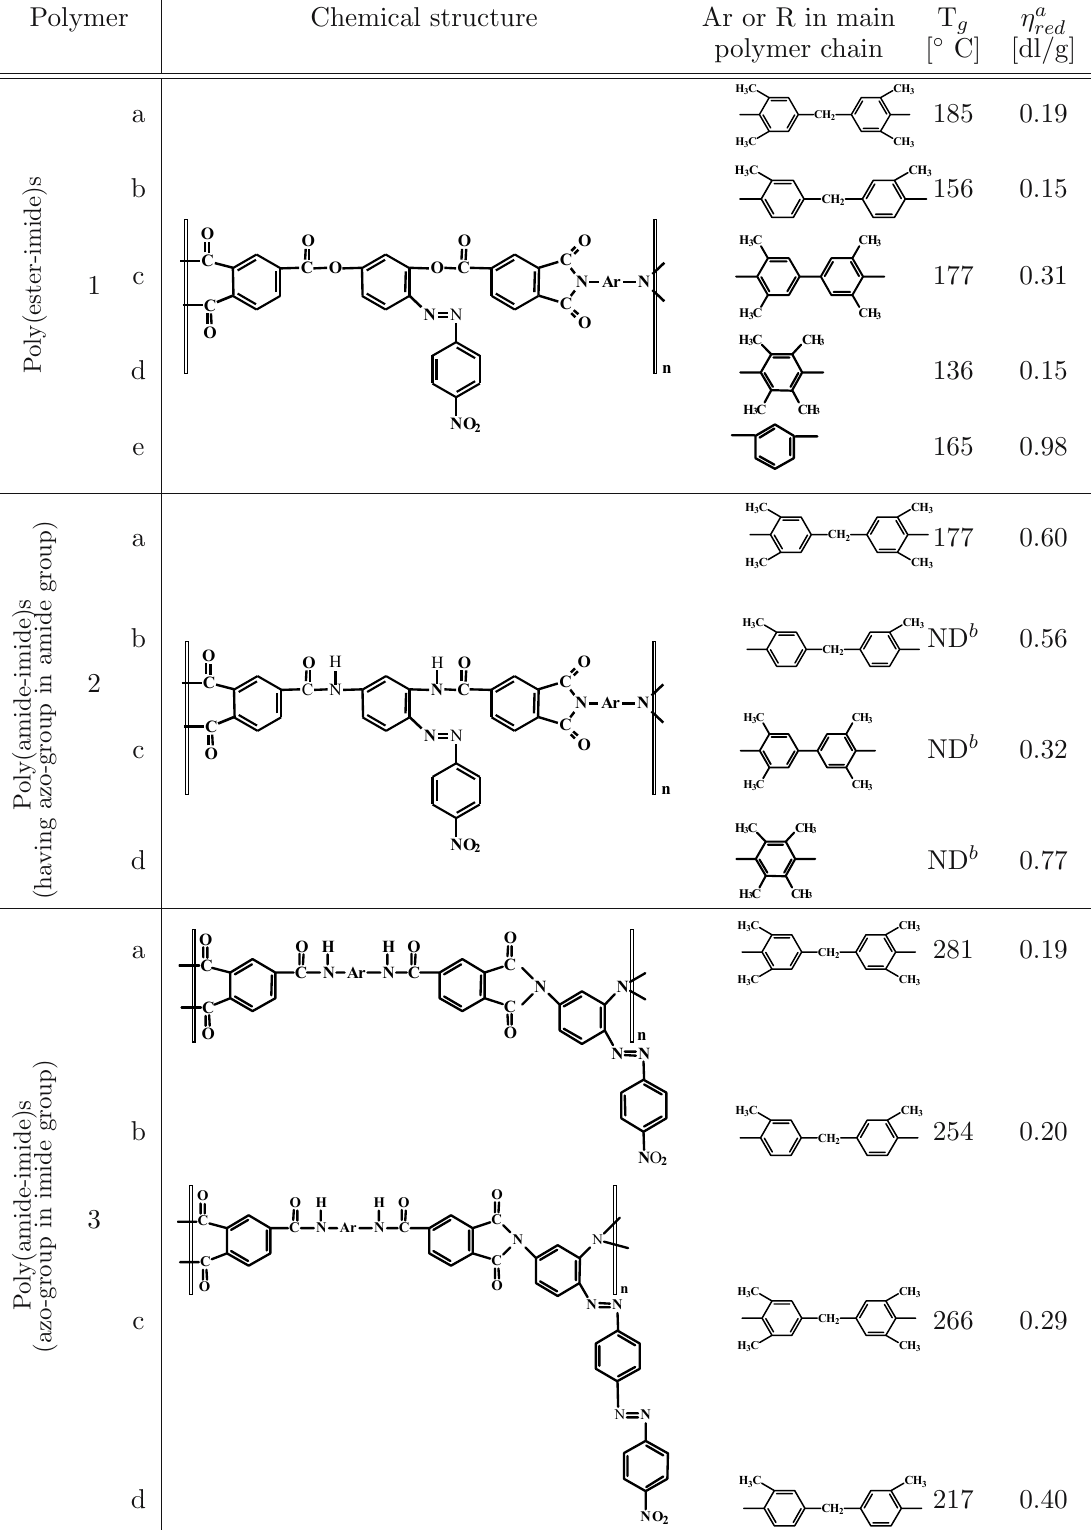
Table 1 Chemical structures of polymers functionalized with azo-groups, their glass transition temperatures T and reduced viscosities η g